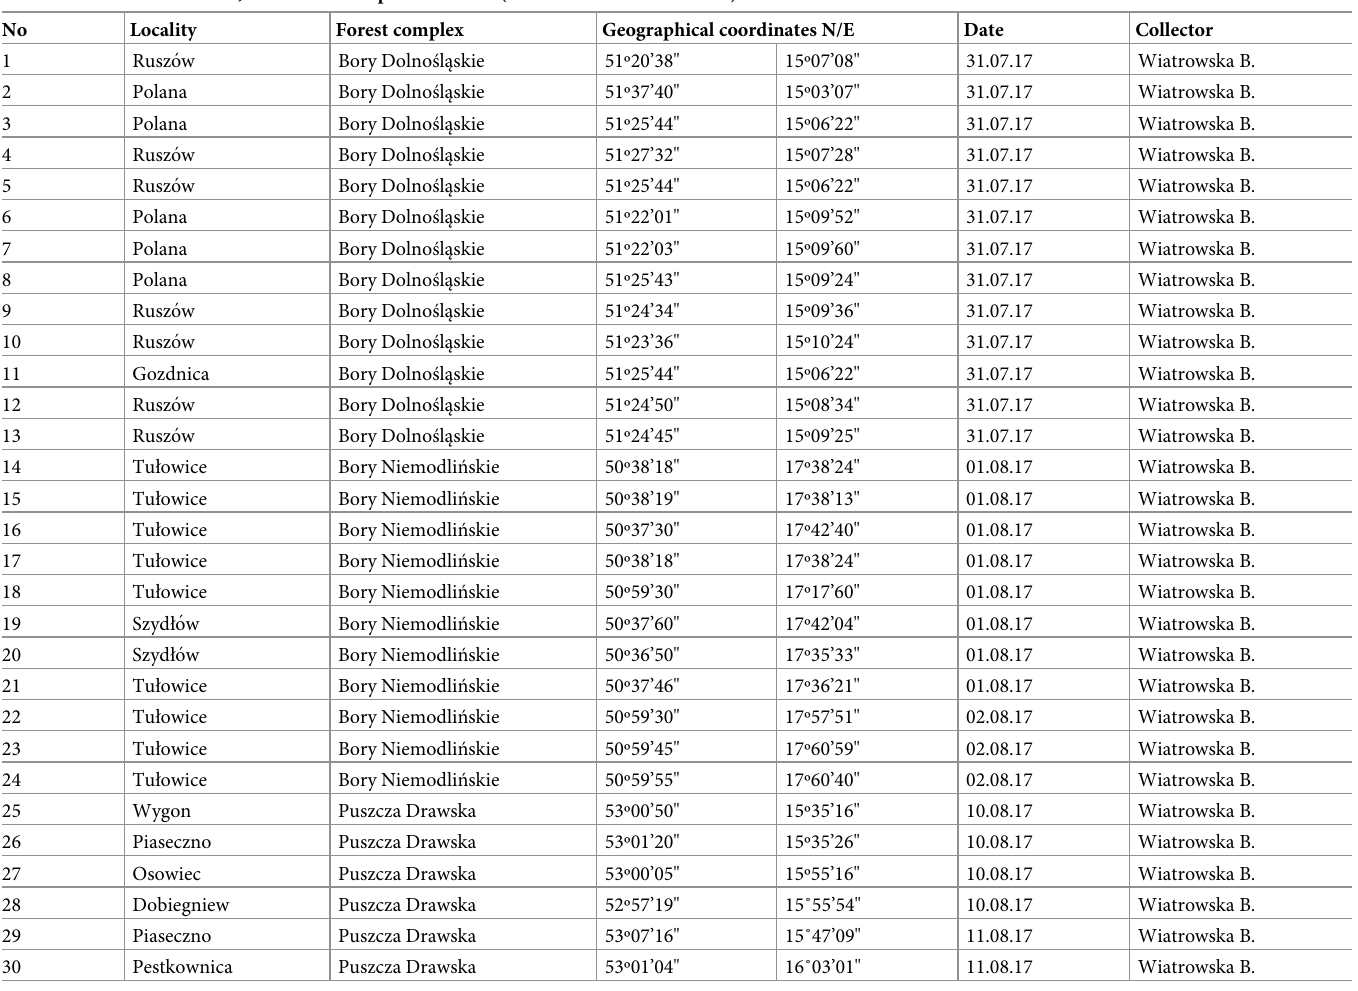
Table 1. The list of localities, from which the plant material ( S . tomentosa inflorescences) was